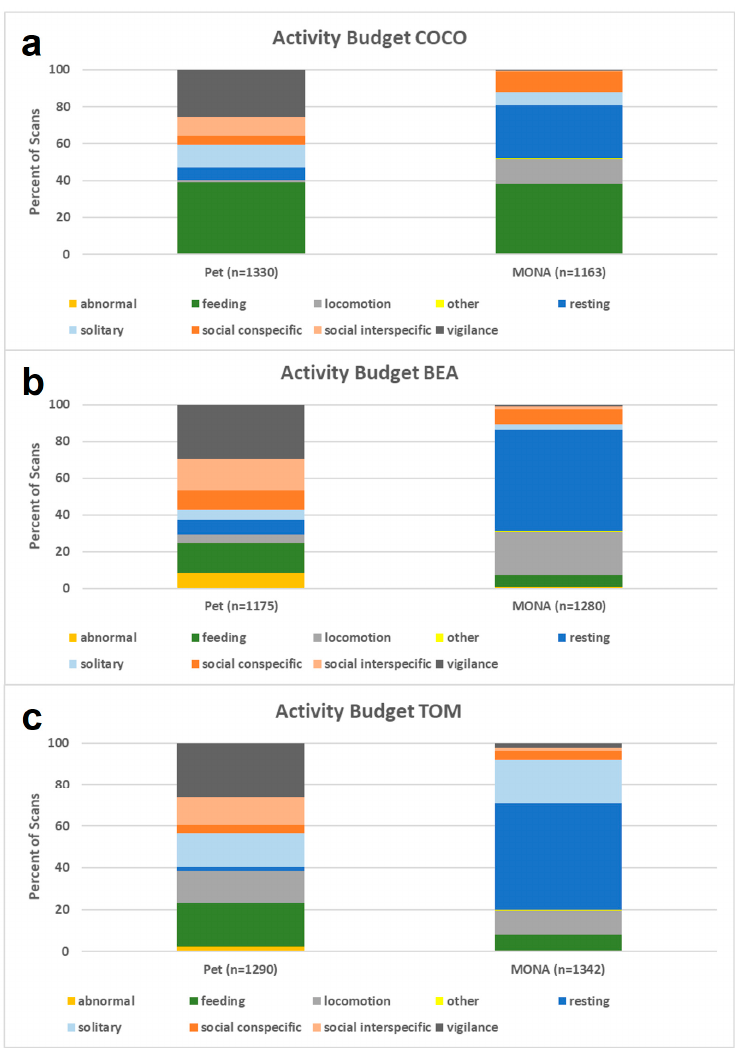
Figure 2. Comparison of the activity budgets while housed as pets (left) and after living at MONA for about 10 years (right) for ( a ) Coco, ( b ) Bea and ( c ) Tom. When we compared the proportion of time spent on the different subcategories of feeding behaviour—i.e., food intake, food manipulation and foraging (see Figure 3)—we found an increase in the proportion of food intake (27.9% vs. 74.4%) at the expense of food manipulation (44.7% vs. 13.4%) and foraging (27.4% vs. 12.2%) in Bea. Whereas the proportions did not change for Coco and Tom (food intake: Coco: 66.0% vs. 68.9%, Tom: 66.8% vs. 62.7%; food manipulation: Coco: 10.6% vs. 7.3%, Tom: 22.1% vs. 22.5%; forage: Coco: 23.4% vs. 23.8%, Tom: 11.1% vs. 14.7%; Figure Figure 3. Comparison of the proportions spent on the different subcategories of feeding behaviour while housed as pets and at MONA for Coco ( left ), Bea ( middle ) and Tom ( right ).